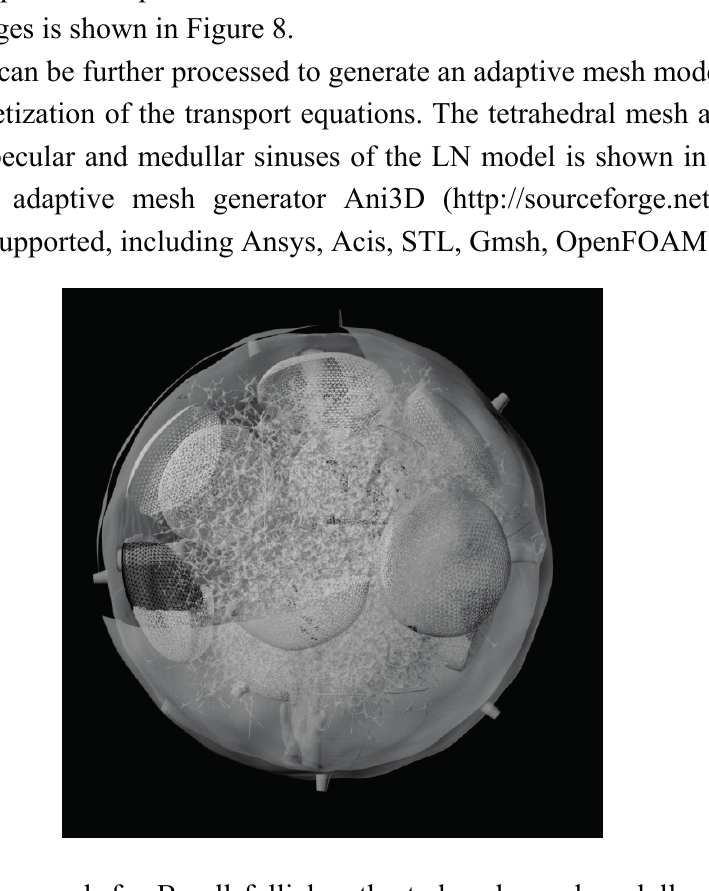
Figure 9. Adaptive mesh for B cell follicles, the trabecular and medullar sinuses of the geometrical LN model generated using tetrahedral spatial discretization software